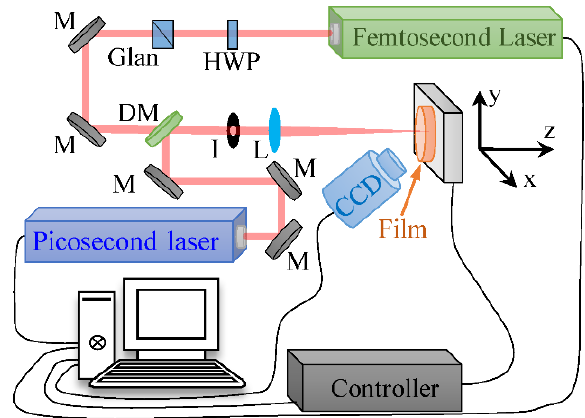
Figure 2. Experimental setup for the damage of femtosecond and picosecond lasers to the multi- layer film.